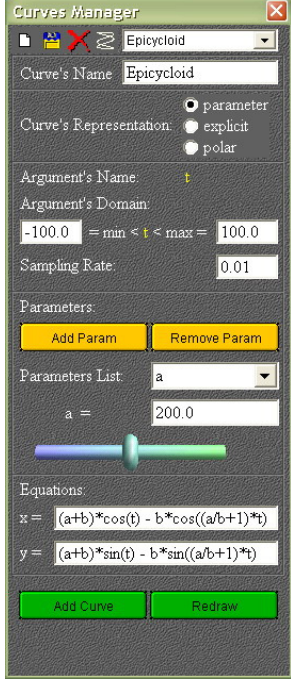
Figure 3. Curve manager (toolbar buttons and